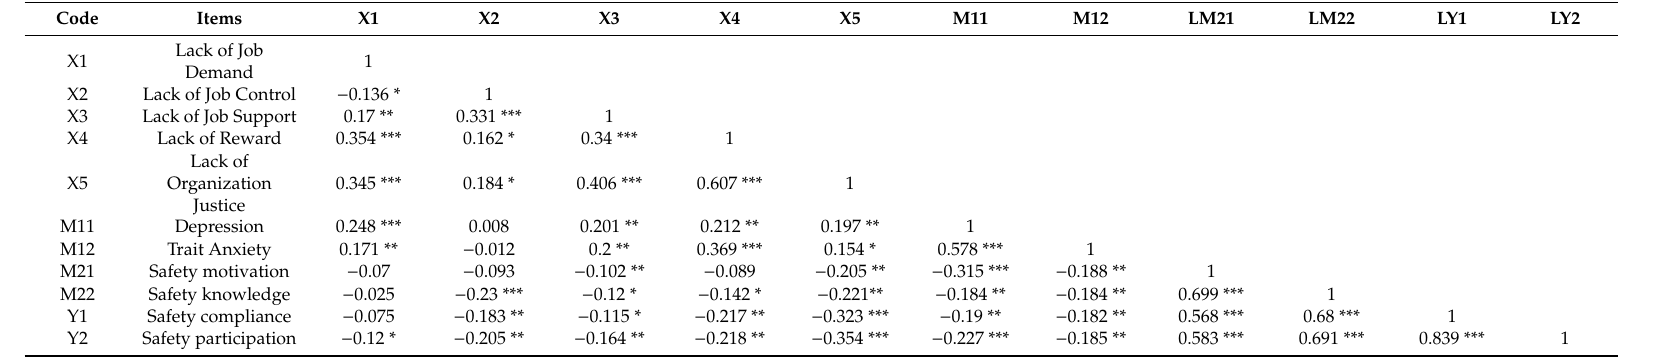
Table 8. Correlation matrix of the research